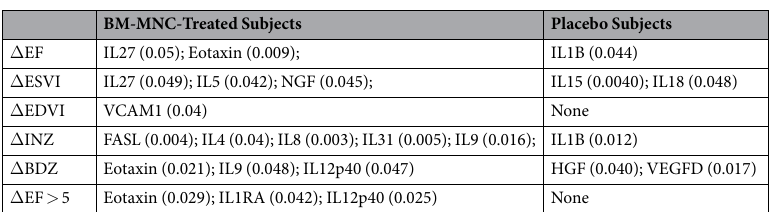
Table 2. Biomarkers with a p value < 0.05 between responders vs. non-responders for different outcome metrics in both BM-MNC-treated and placebo